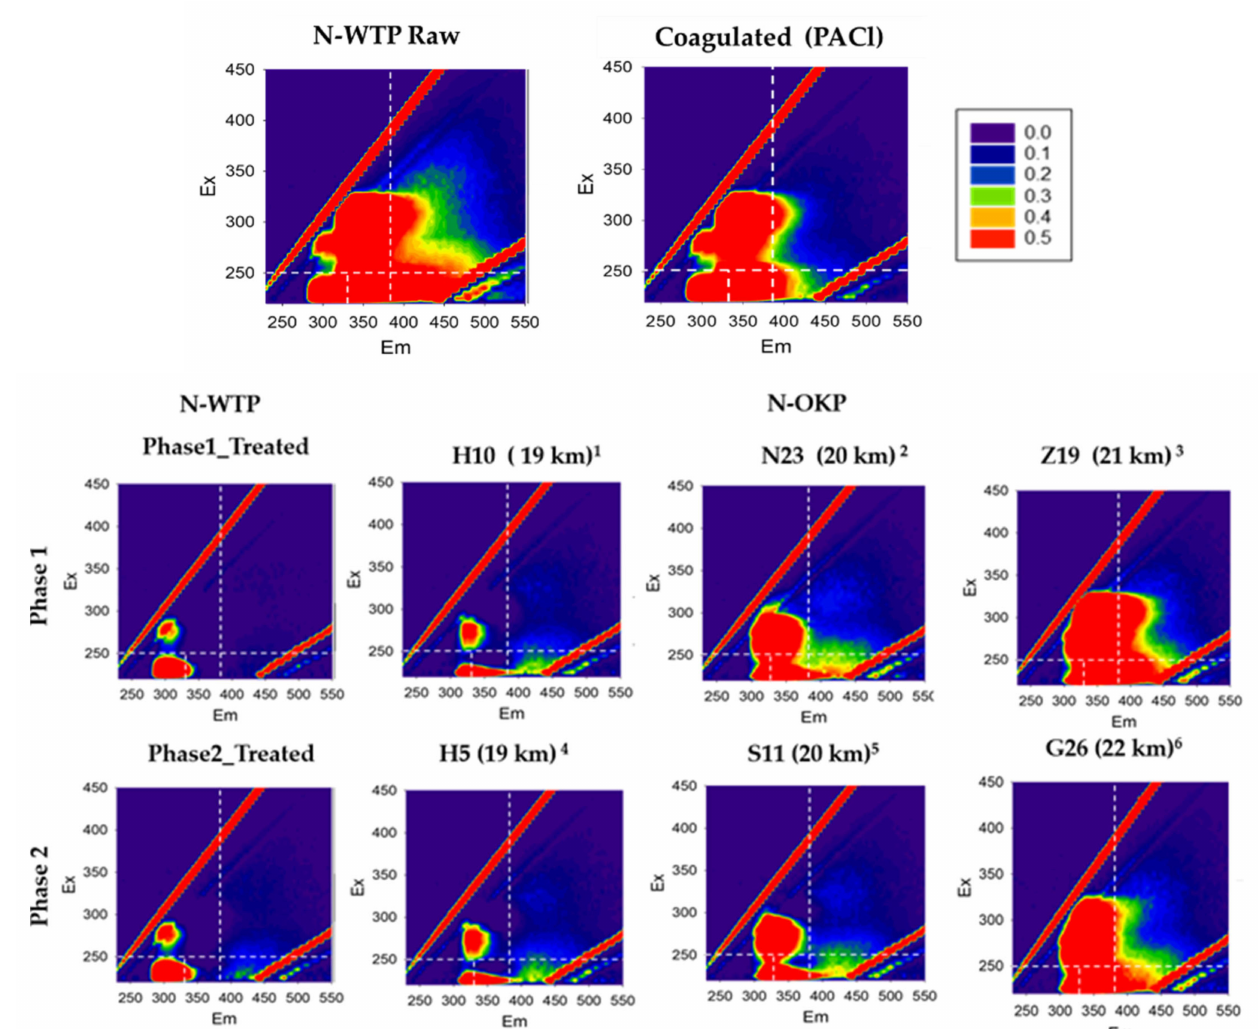
Figure 8. EEM in N-WTP and in N-OKP. 1 Hta Ward, 2 Nya Ward, 3 Zaa Ward, 4 Hta Ward, 5 Sa a Ward, 6 Gaa Ward.